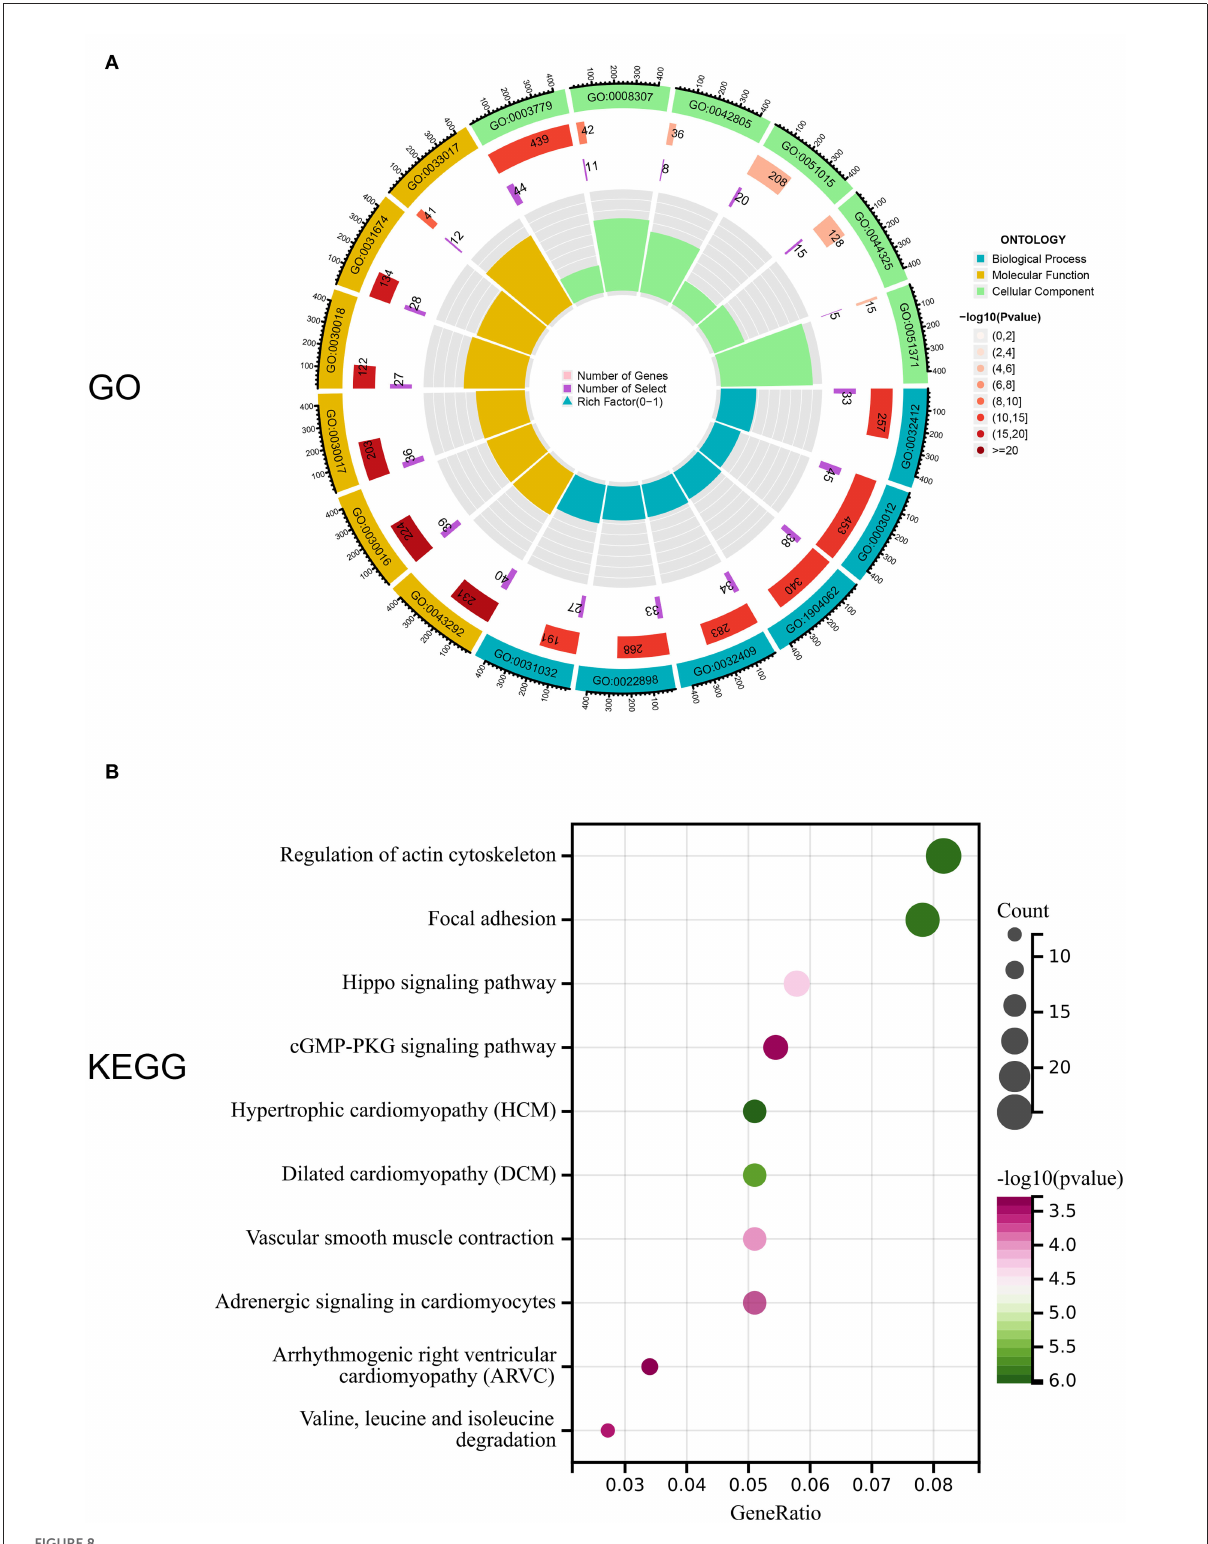
FIGURE8 Enrichment analysis of common DEGs. (A) Gene ontology (GO) enrichment analysis of 657 common DEGs in biological functions (BFs), molecular functions (MFs), and cellular constitutions (CCs). (B) Kyoto Encyclopedia of Genes and Genomes (KEGG) enrichment analysis for 657,657 common